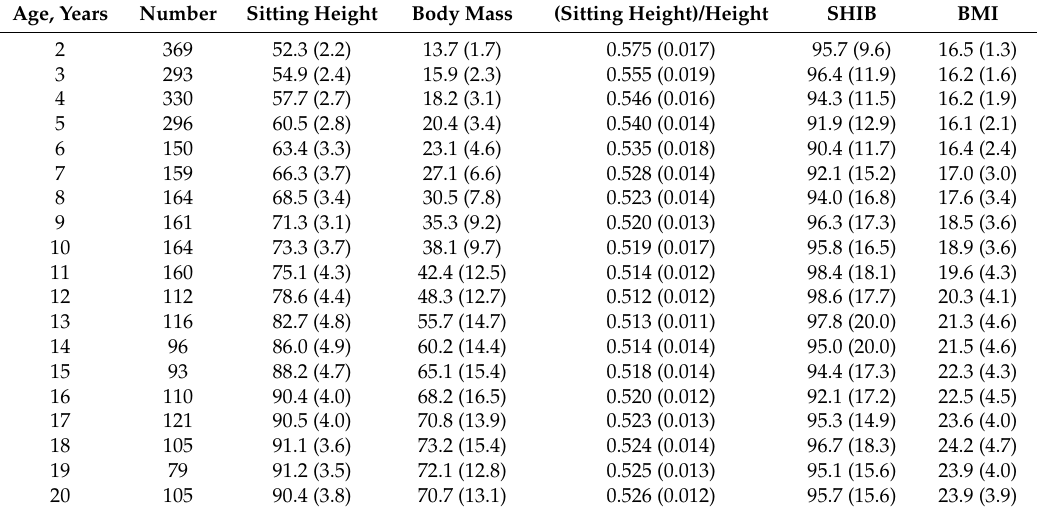
Table 1. Sample sizes and means (with standard deviations in brackets) of sitting height (cm), body mass (kg), ratio of sitting height to standing height, sitting-height index of build (SHIB, kg/m 3 ) and body mass index (BMI, kg/m 2 ) of white males. The data are from the NHANES III laboratory data file [15].